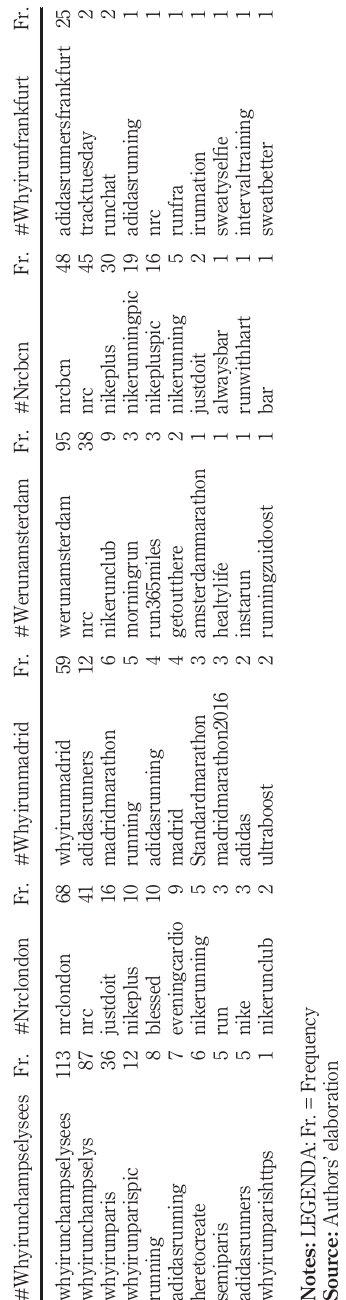
Table II. Top ten hashtags per